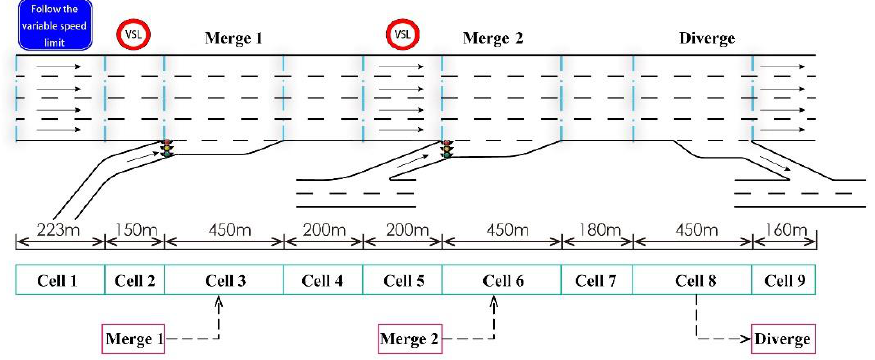
Figure 10. Simulation segment structure and Cell division results.